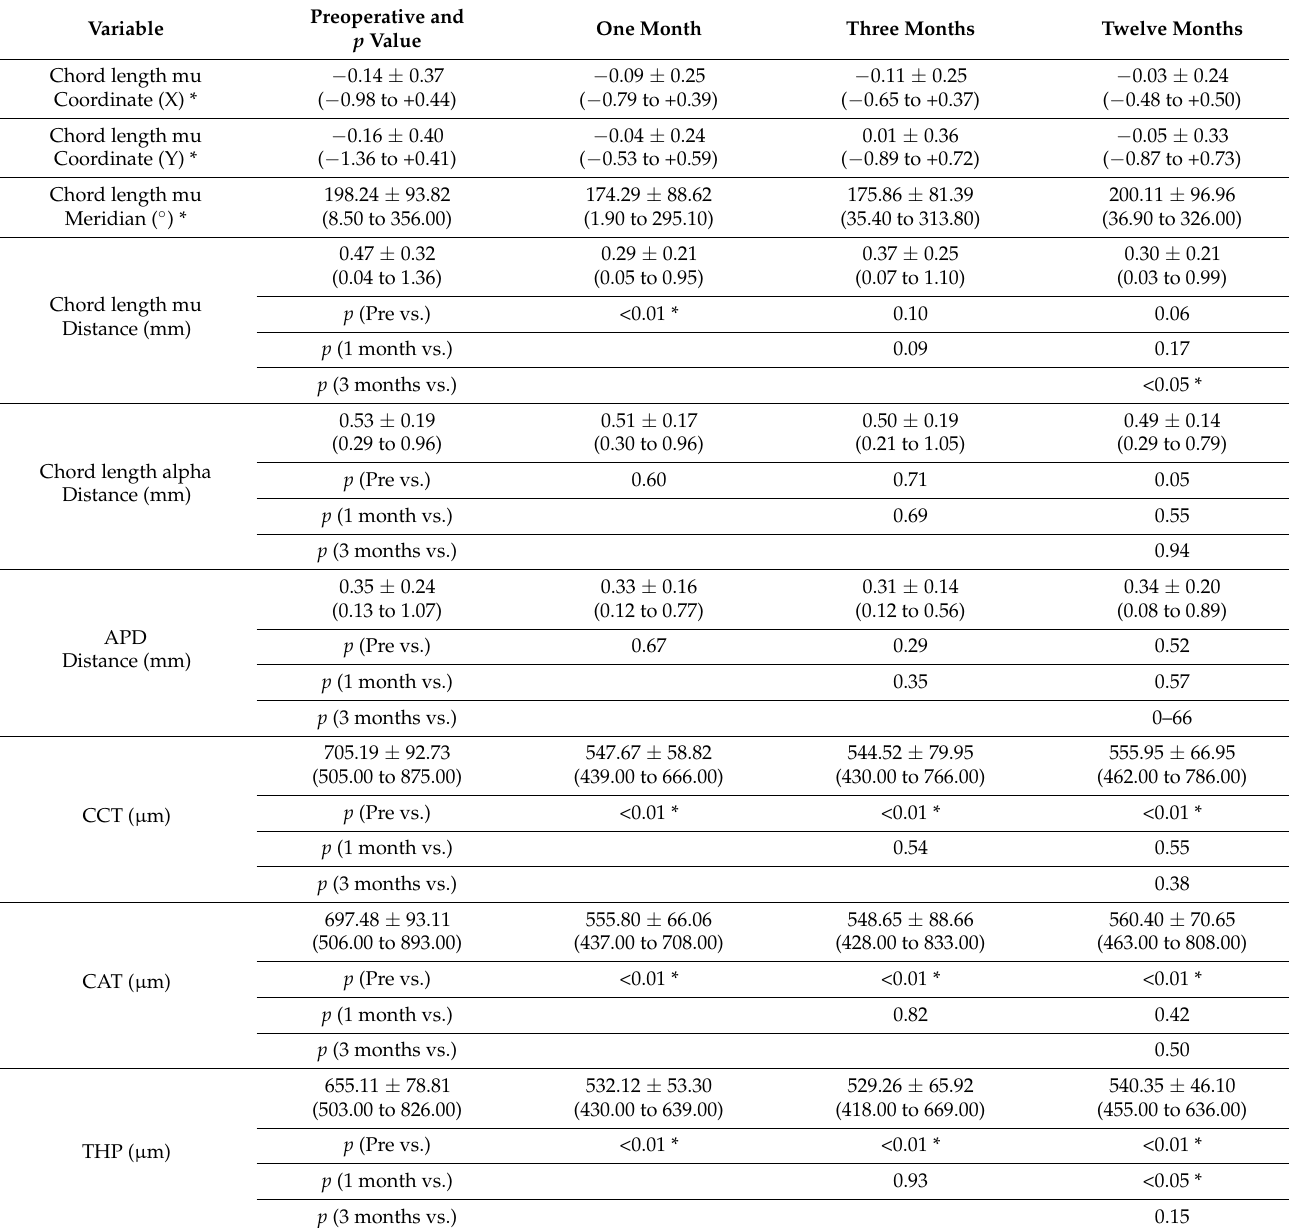
Table 1. Descriptive analysis represented by mean ± standard deviation